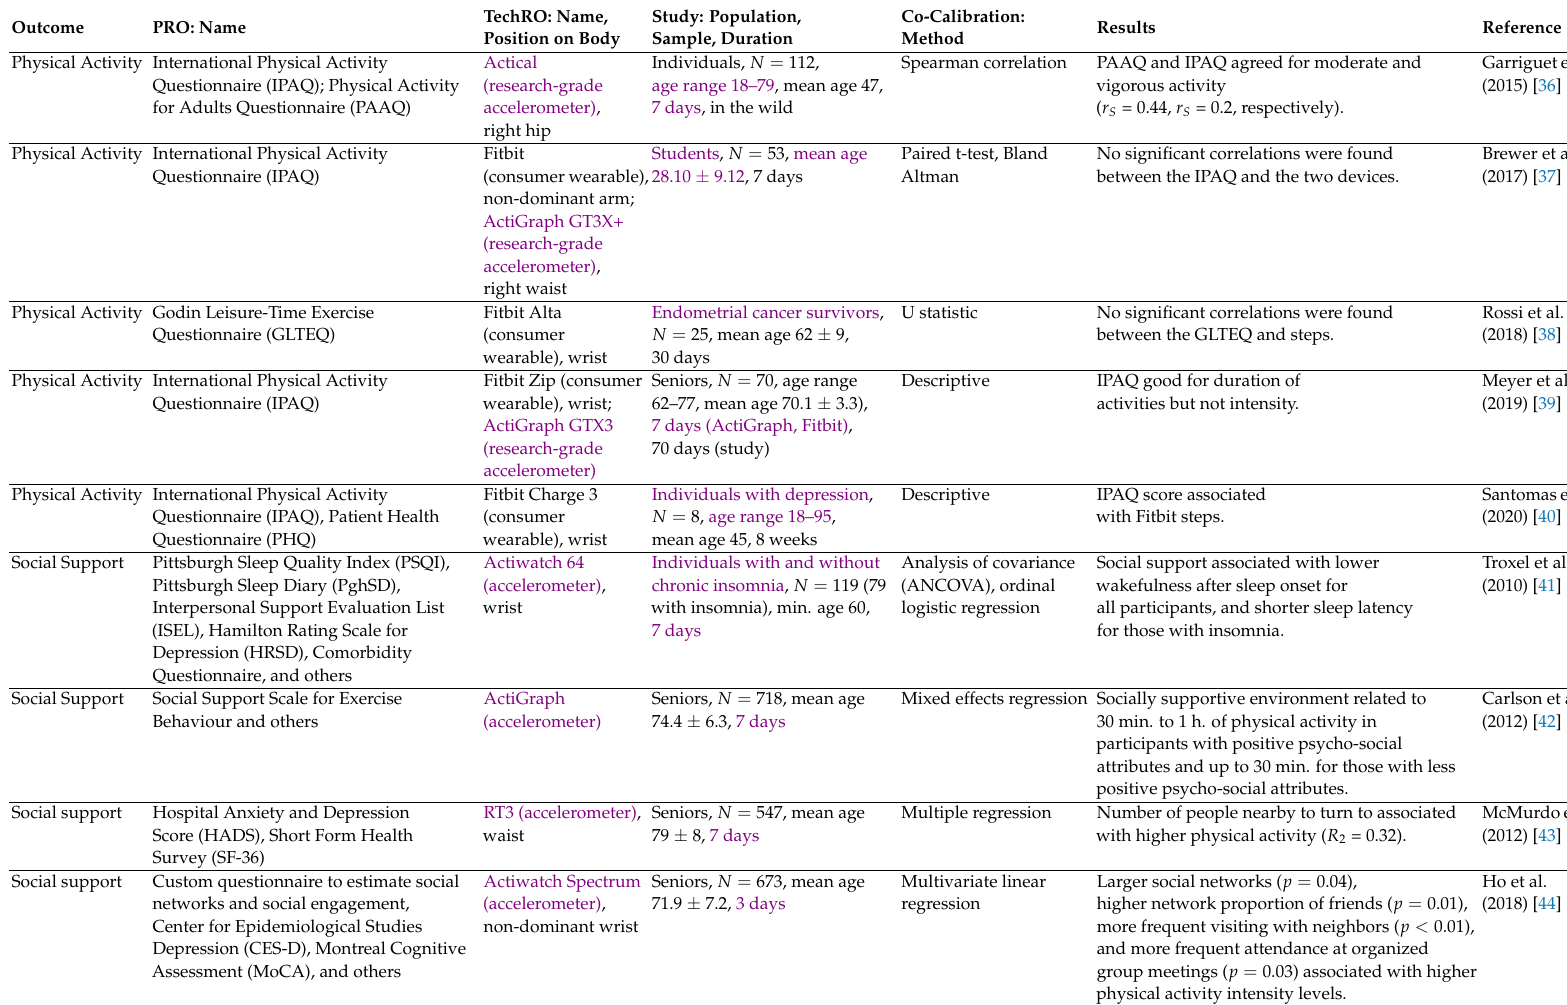
Table 1. Previous PRO-TechRO Co-Calibration